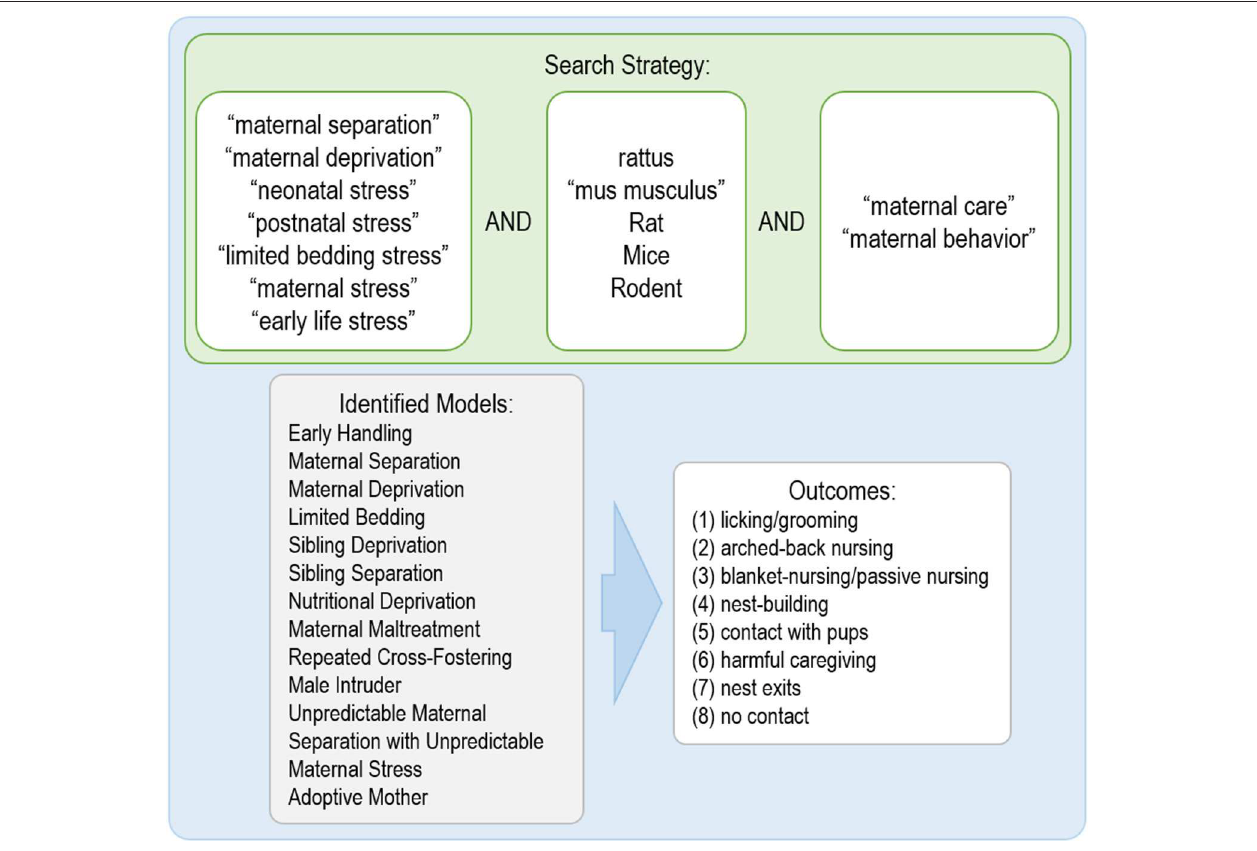
FIGURE 1 | Terms used for the search, identified models in the studies and behavioral outcomes evaluated in the systematic